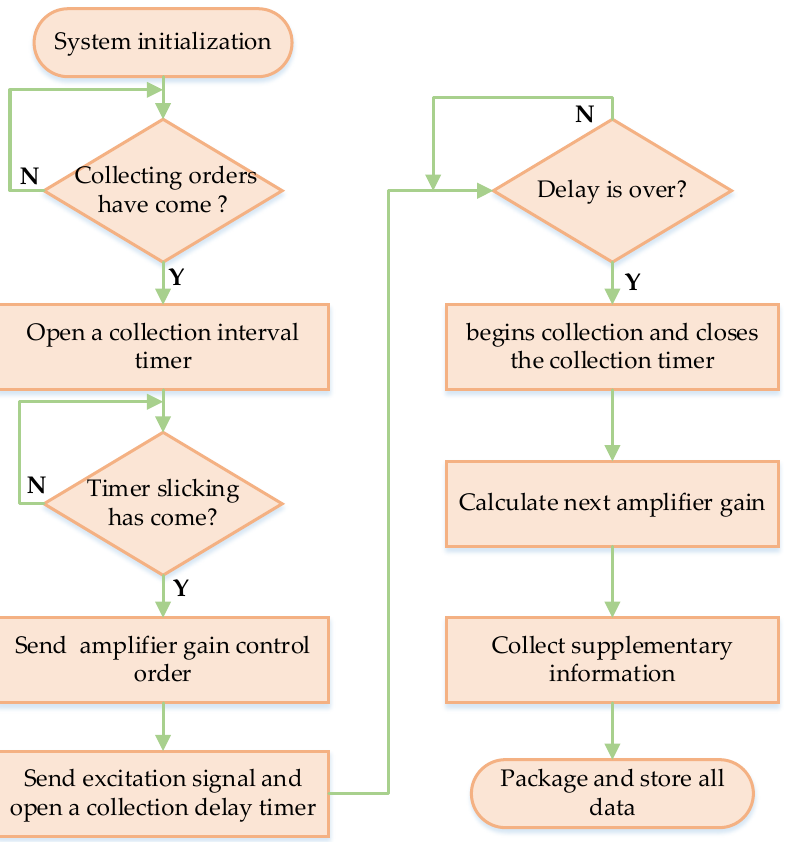
Figure 3. Flowchart of the designed tool working in logging pattern.